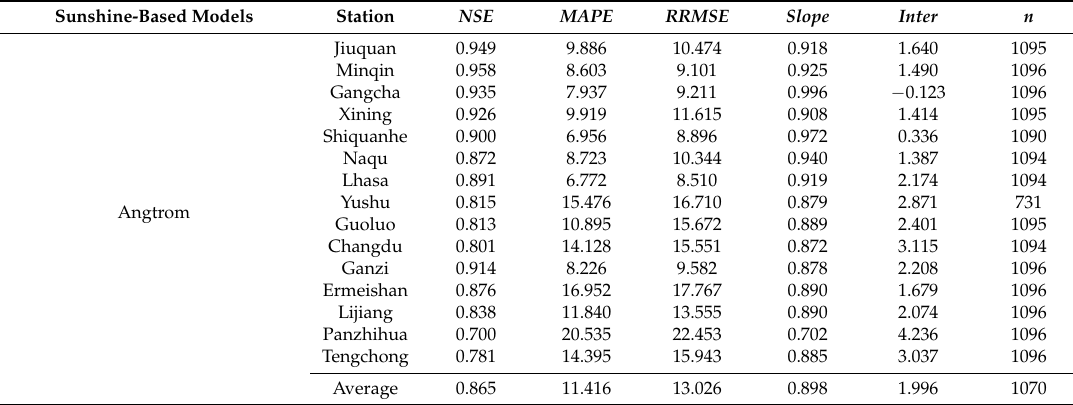
Table 2. Validation of the sunshine- and temperature-based site-dependent models for the calibrated coefficients in Table 1 using data from 2008 to 2010 at different locations in this study. Sunshine-Based